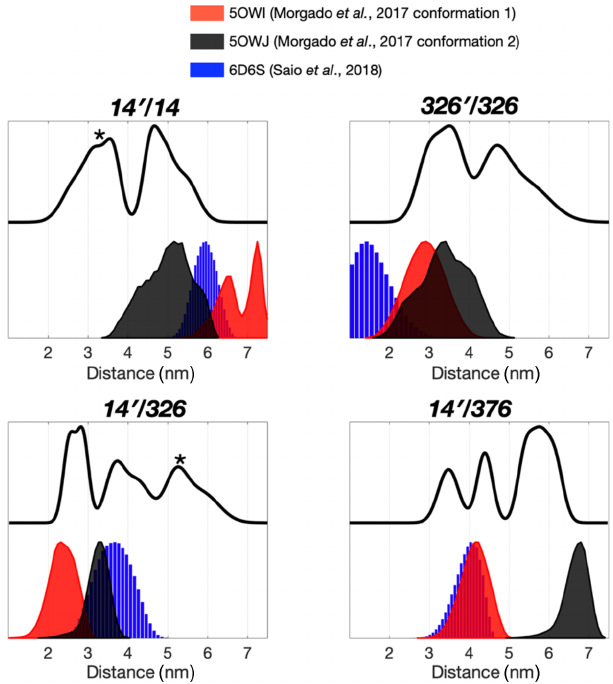
Figure 2. Multiple dimeric TF conformations revealed from the DEER measurements. DEER samples were prepared by either the single species or the 1 : 1 mixture (denoted as site A (cid:48) /site B) of the three single-cysteine variants, 14C, 326C, and 376C. DEER dis- tance distributions of TF dimer (solid line) were compared with the distance distributions calculated from the previously determined TF dimer structure (PDB codes: 5OWI, red; 50WJ, black; and 6D6S, blue). There are a few discrepancies between the DEER and NMR results, as indicated by